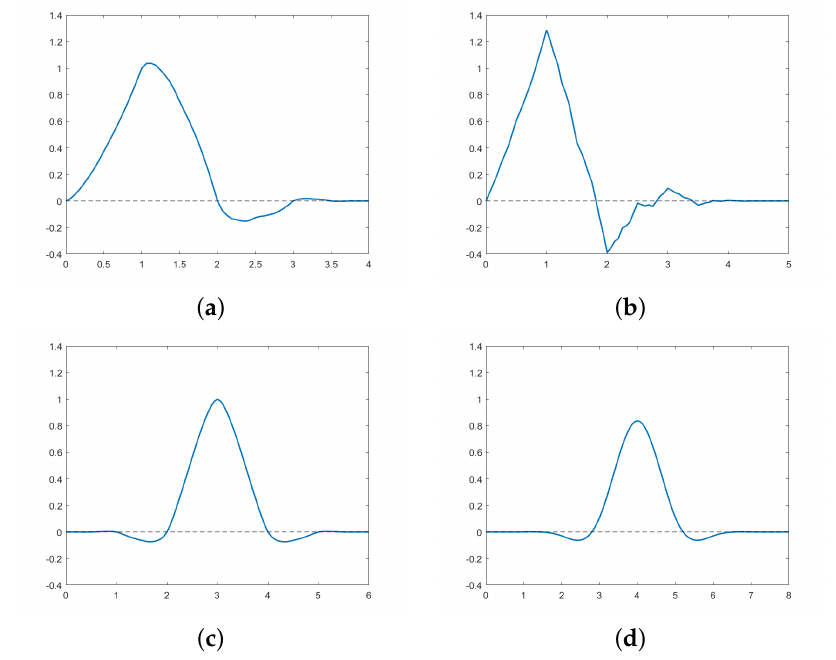
Figure 1. ( a ) The pseudo-spline of type I Φ I interpolatory pseudo-spline Φ II